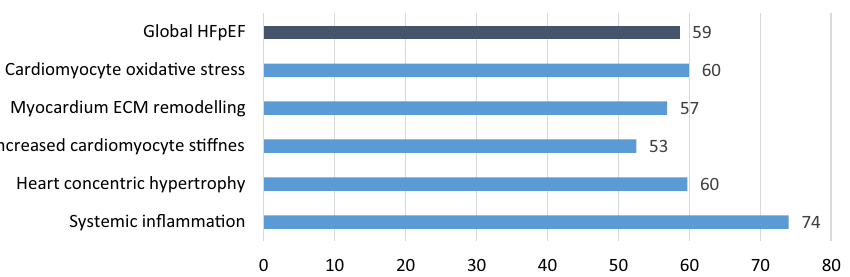
Figure 1. Intensity of empagliflozin therapeutic activity in HFpEF. Data are reported as percentage of effectors modulated by empagliflozin in the mathematical models, in HFpEF (as a whole) and in each individual pathophysiological motif measured. This value indicates empagliflozin’s capability to reverse the protein alterations occurring in HFpEF.